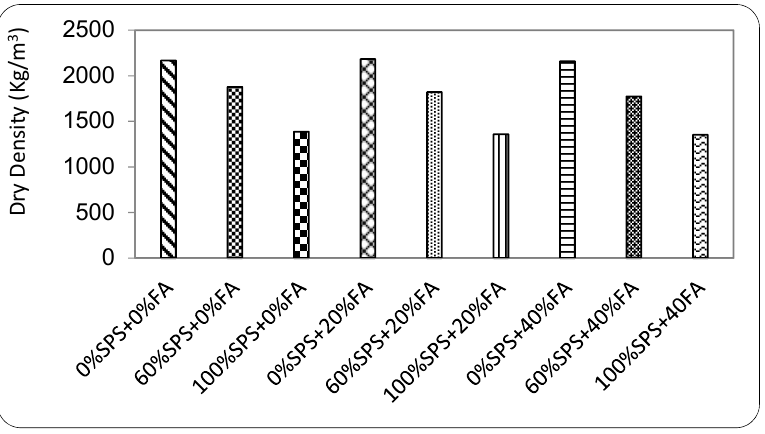
Figure 5. Density of concretes containing SPS aggregate and FA.